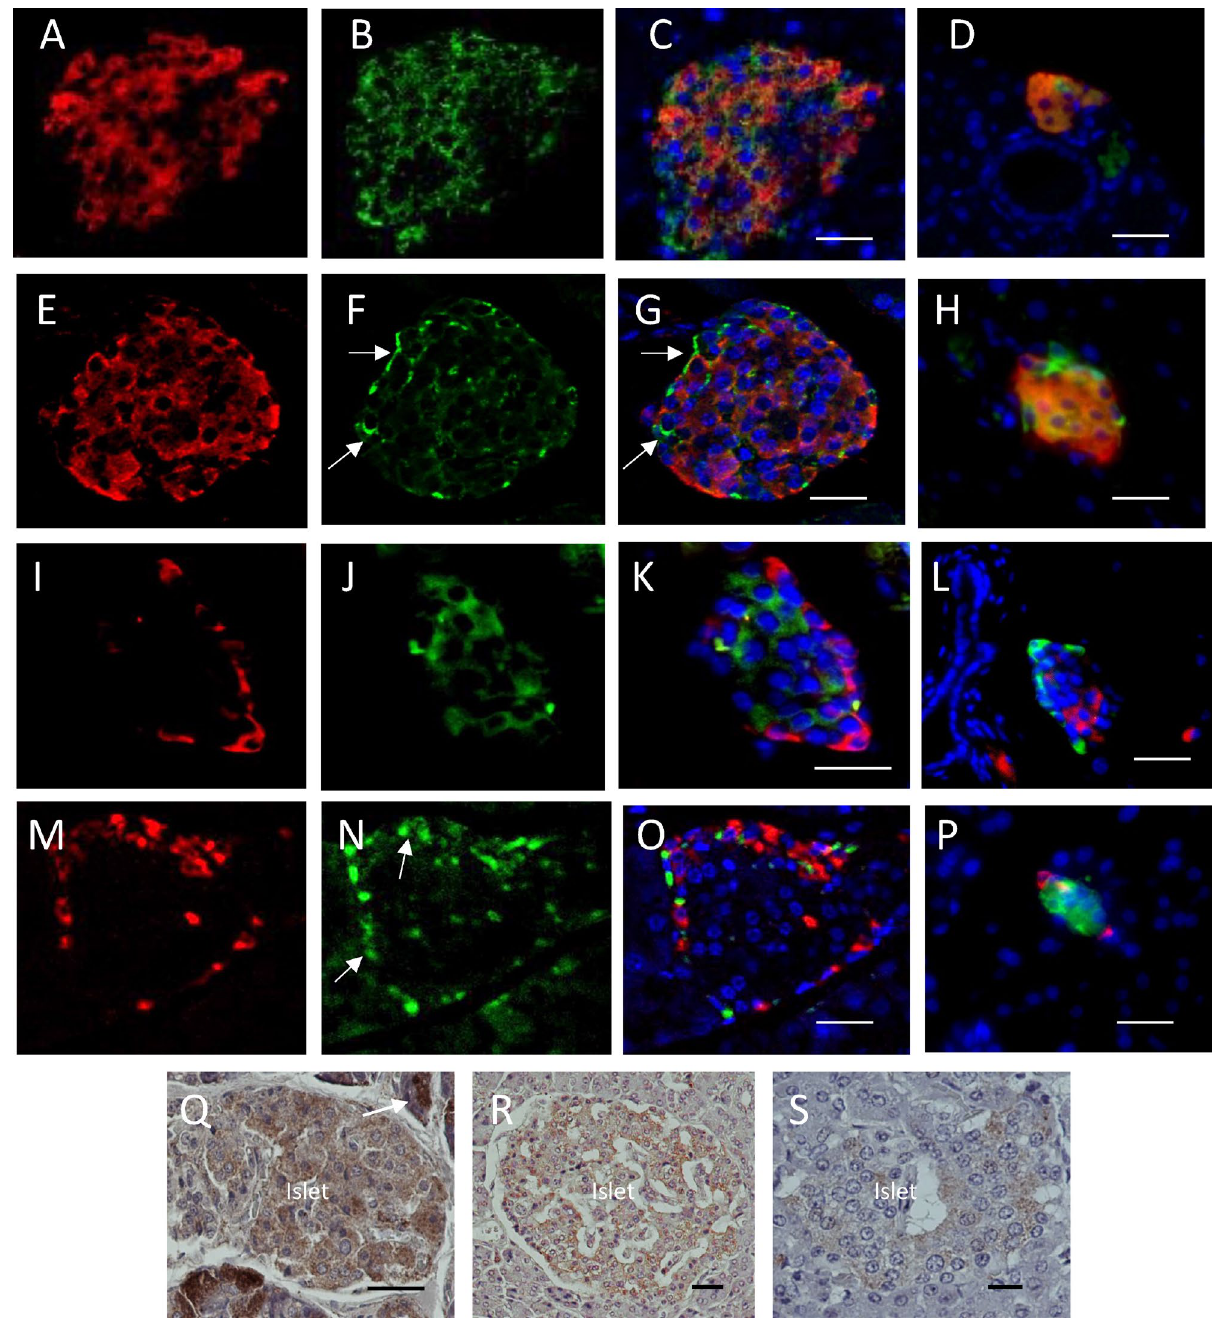
Figure 2. Immunohistochemical co-localization of insulin ( A & E , red), glucagon ( I & M , red), Apelin ( B & J , green) and Aplnr ( F & N , green) in adult mouse islets or extra-endocrine islet clusters ( D , H , L , P ). Merged images are shown for islets in ( C ), ( G ), ( K ) and ( O ) and for clusters. In merged images nuclei are shown stained with DAPI (blue). Arrows indicate the localization of Aplnr with the β-cell membranes. Immunohistochemical localization of Apelin in human pancreas is shown in panels ( Q – S ). Tissue donors were aged 4 months in ( Q ), 18 years in ( R ) and 41 years in ( S ). Apelin is localized to islet cells at all ages (Islet) and to acinar tissue (arrows) at 4 months. Bar represents 50 (Fig. 5A) while having no detrimental effect alone. This suggests that any endogenous release of Apelin or Apela from INS1E cells was minimal. We also examined the ability of Apelin to increase β-cell DNA synthesis within islets isolated from neonatal mice. Immunohistochemistry was performed on whole islets to co-localize insulin and Ki67 as a measure of β-cells in G1 and S phase of cell replication (Fig. 5B,C). Apelin significantly increased DNA synthesis in β-cells, as measured by co-localization of insulin and Ki67, at 100 nM but not at greater con- centrations (Fig. 5D).